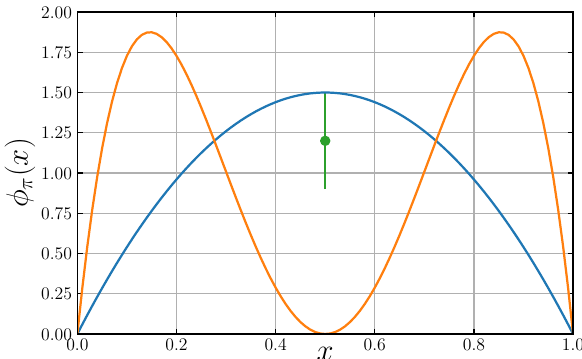
Figure 1 . Models for the pion LCDA: the blue line shows the asymptotic shape corresponding to the limit (cid:22) ! 1 , while the orange line depicts the CZ model [8, 10] for (cid:22) = 0 : 5 GeV. The green point shows the QCD light-cone sum rule result [16] for the mid-point at (cid:22) = 1